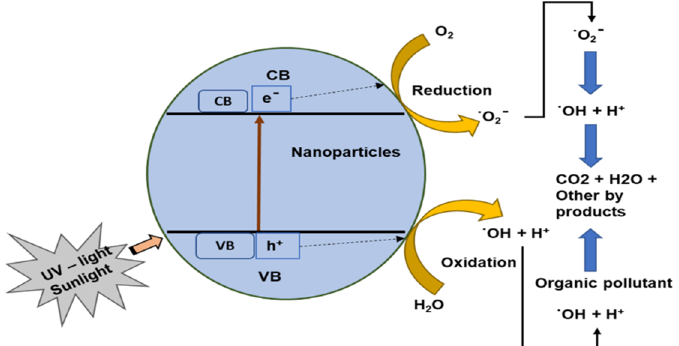
Figure 1. A schematic diagram for the production of reactive oxygen and hydroxyl radicals.